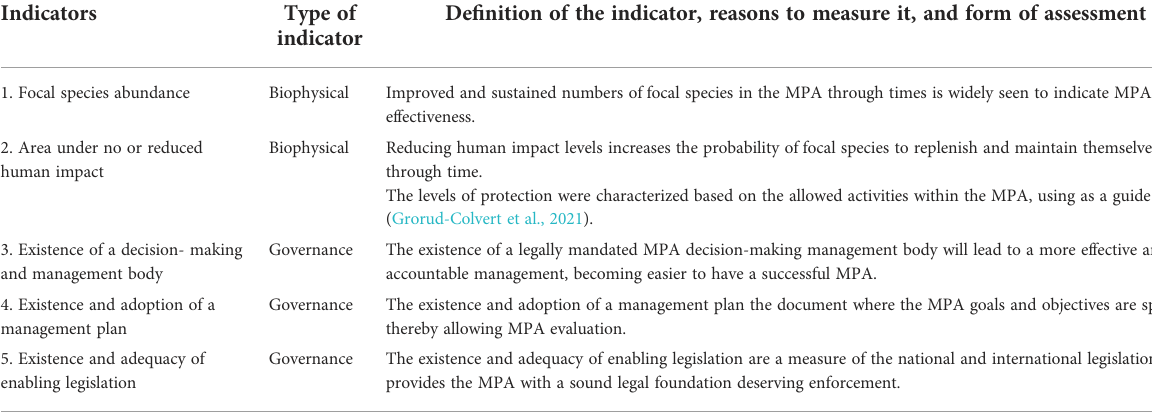
TABLE 1 Matching indicators chosen in the view of the abovementioned